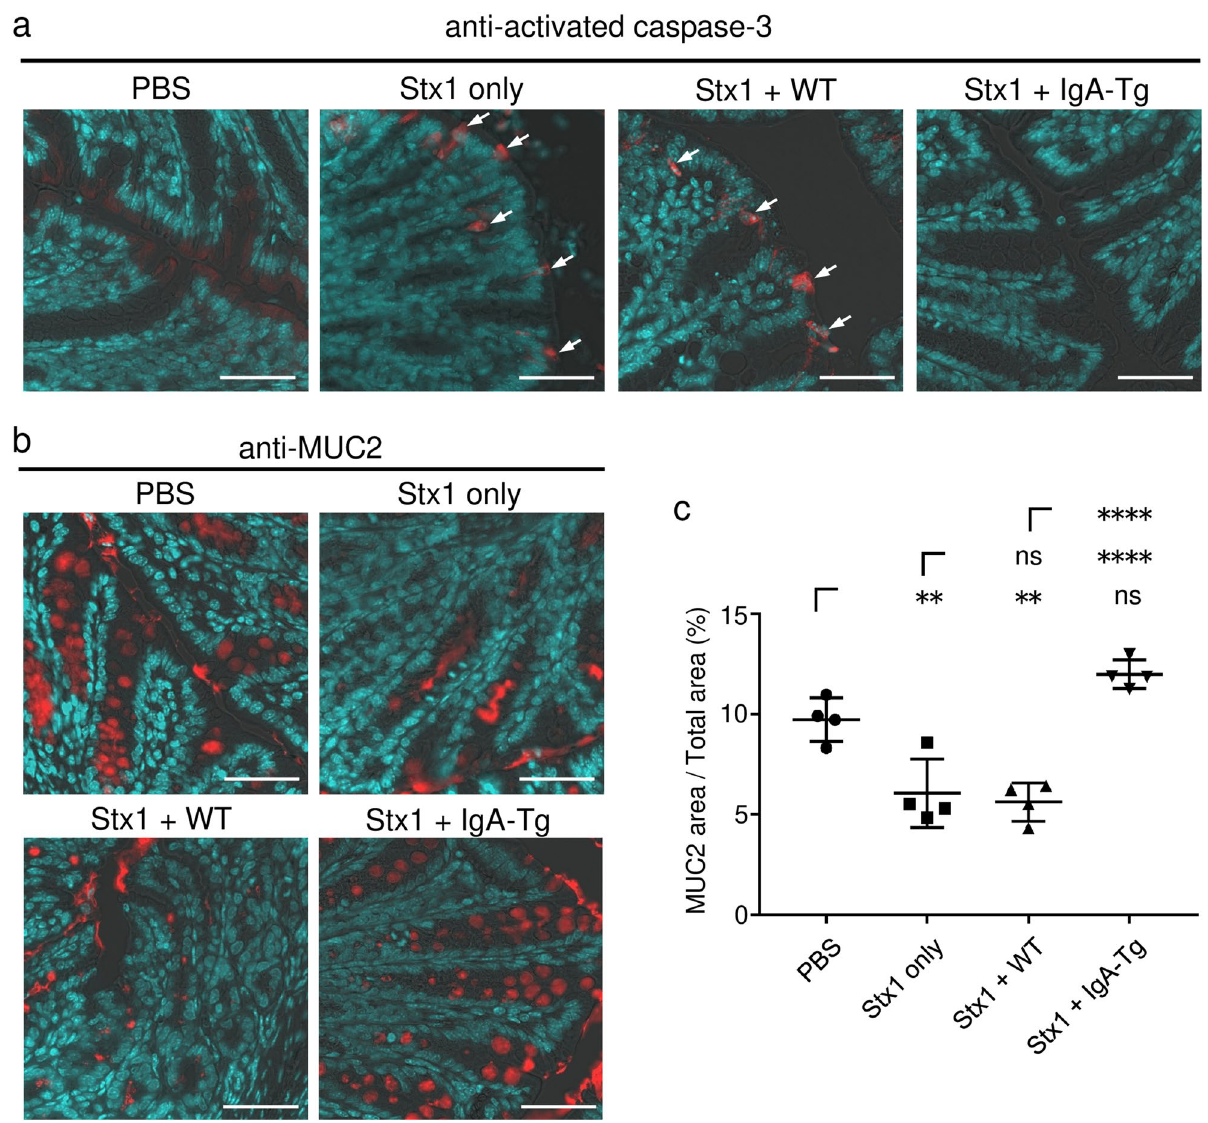
Figure 5. Prevention of Stx1-caused colon injury by an IgA plantibody specific for Stx1. Sixty ng of Stx1 was treated with the leaf extract of an IgA transgenic plant (Stx1 + IgA-Tg) containing 8 μg IgA (1.6 mg total proteins), that of a wild-type plant (Stx1 + WT) containing 1.6 mg of total protein, or PBS (indicated as Stx1 only) for 1 h. Mice were then exposed to each sample containing Stx1 or to PBS alone (indicated as PBS) through intrarectal administration. After 16 h, colon tissues were collected and embedded in O.C.T. compound. Frozen sections of the colon tissues were stained with anti-activated caspase-3 ( a ) or anti-MUC2 ( b,c ) antibodies. Nuclei were counterstained with DAPI ( a,b ). Arrows indicate signals from activated caspase-3 ( a ). Bars represent 50 μm. The percentages of the MUC2-positive area divided by the total area of the mucous epithelium are plotted ( c ). Horizontal bars represent the means for individual groups and error bars are SD ( n = 4). There were no exclusions of data points. Statistical significance was analyzed by ANOVA followed by the Tukey test. ** P < 0.01, **** P < 0.0001, ns P >